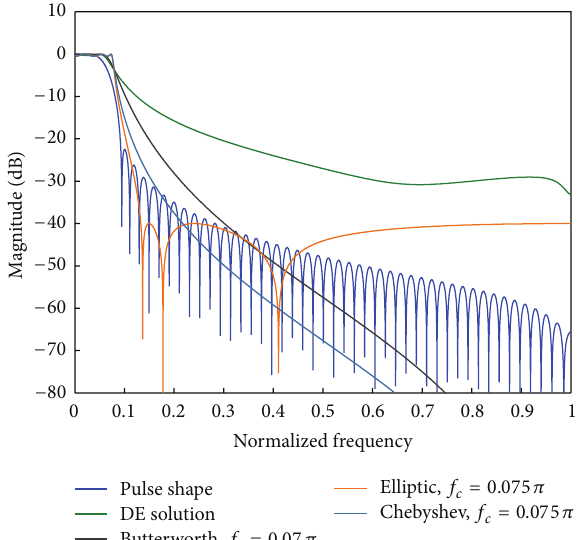
Figure 11: Magnitude responses of transmission, DE optimised and referencefilters.DEoptimisedandreferencefiltersaredesignedwith order 6.